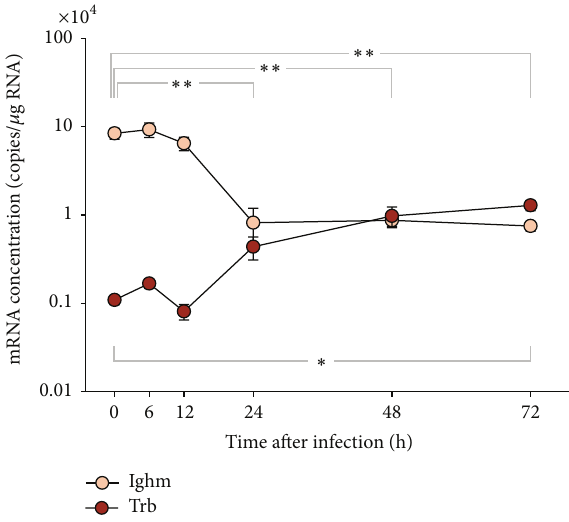
Figure 6: Dynamics of T and B cell migration in head kidney after infection. Ordinate shows the relative number of mRNA copies (per 𝜇 g total RNA) encoding the T cell receptor beta (TRB) and immunoglobulin M (Ighm) inhead kidney of five individuals/time point at various times after infection (abscissa). Values are given as mean ± SEM. Note that the relative quantity is presented on a log10 scale.Asterisksdenotestatisticalsignificancewith 𝑝 < 0.01 ( ∗∗ )and 𝑝 < 0.05 ( ∗ ) compared to controls above ( ighm ) and below ( trb ) the graph. Statistical significance was assessed with a double sided 𝑡